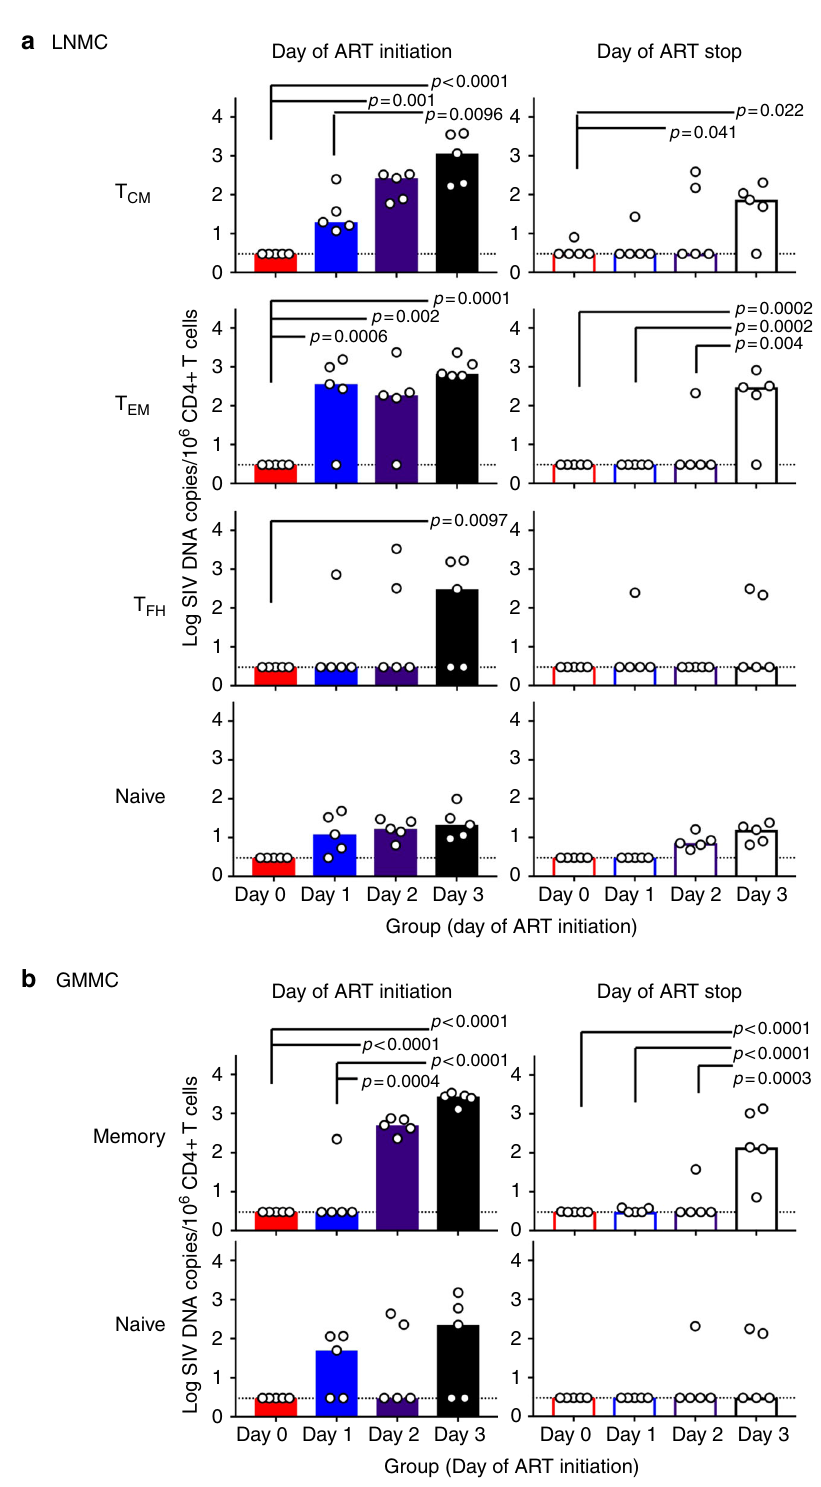
Fig. 3 Comparison of SIV DNA in CD4 + memory T cell subsets. Mononuclear cells were isolated from tissues of animals that initiated ART on days 0, 1, 2 and 3 following infection and sorted into populations of CD4 + T cells: a lymph node naïve, central memory (T CM ), follicular helper T cells (T FH ) and effector memory (T EM ); b colon naive and memory. SIV DNA is expressed as log copies/10 6 CD4 + T cells at the time of ART initiation and stopping ART. All data points are shown with the median expressed as bars. p values re fl ect t -tests that were used to compare means of proviral DNA in each subset between each